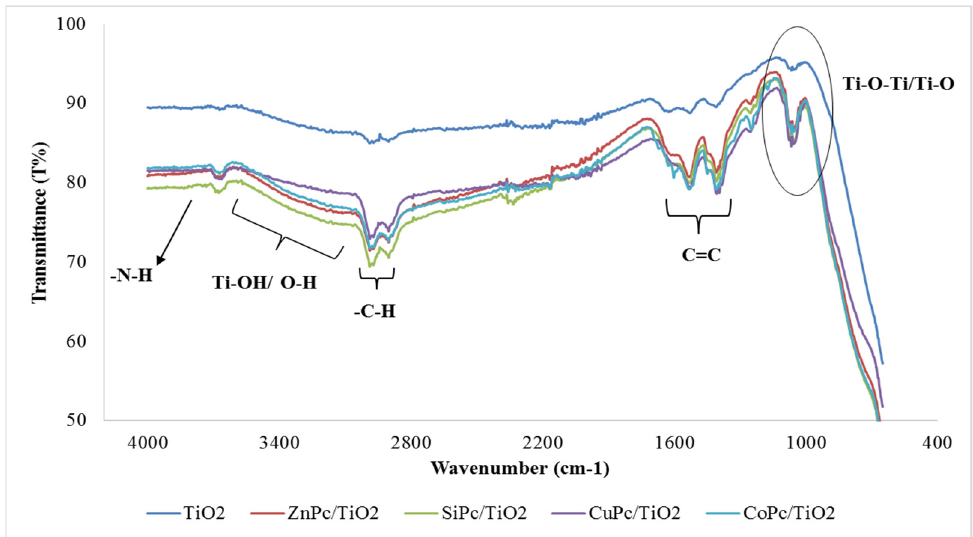
Figure 6. FT-IR spectrums of TiO 2 and MPc/TiO 2 catalysts prepared without TX-100. Stretching and vibration between Ti and O are ranked in the fingerprint region de- scribed at 1250 cm − 1 and below this value. Diaristic peaks rising at about 690 cm − 1 and 800– 450 cm − 1 are remarked, respectively, as Ti-O-Ti and Ti-O stretching peaks as already given in the current literature [14,24,61].